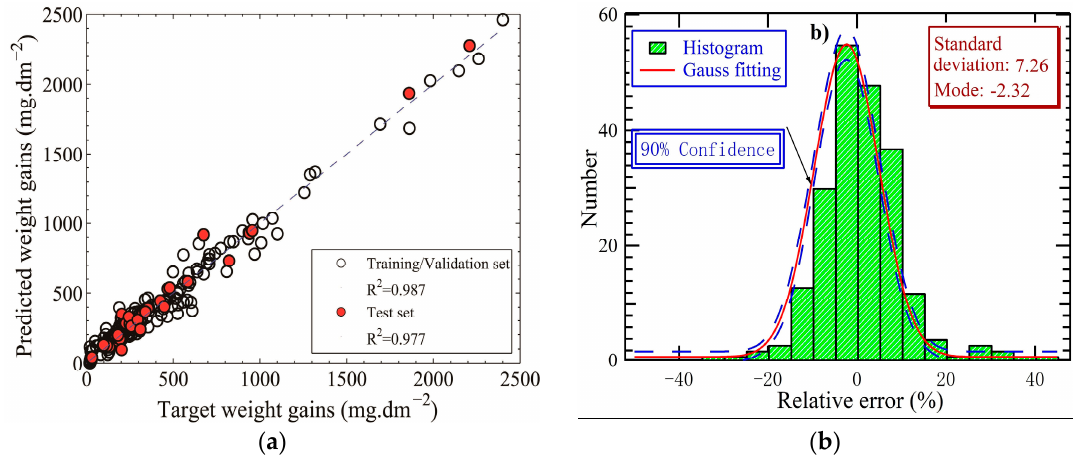
Figure 2. ( a ) Neural network predicted versus target outputs, and ( b ) statistics on the relative errors of artificial neural network (ANN) predictions.